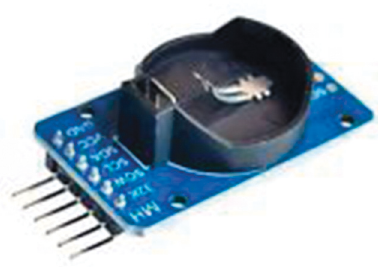
Figure 5: RTC DS3231 RTC (as adopted from https://learn. adafruit.com/adafruit-ds3231-precision-rtc-breakout).